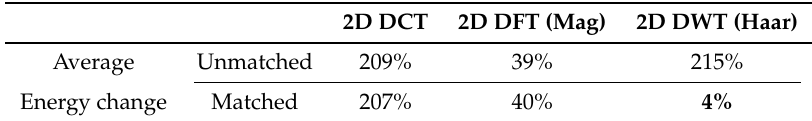
Table 1. Average energy change between coefficients of center and synthesized images.